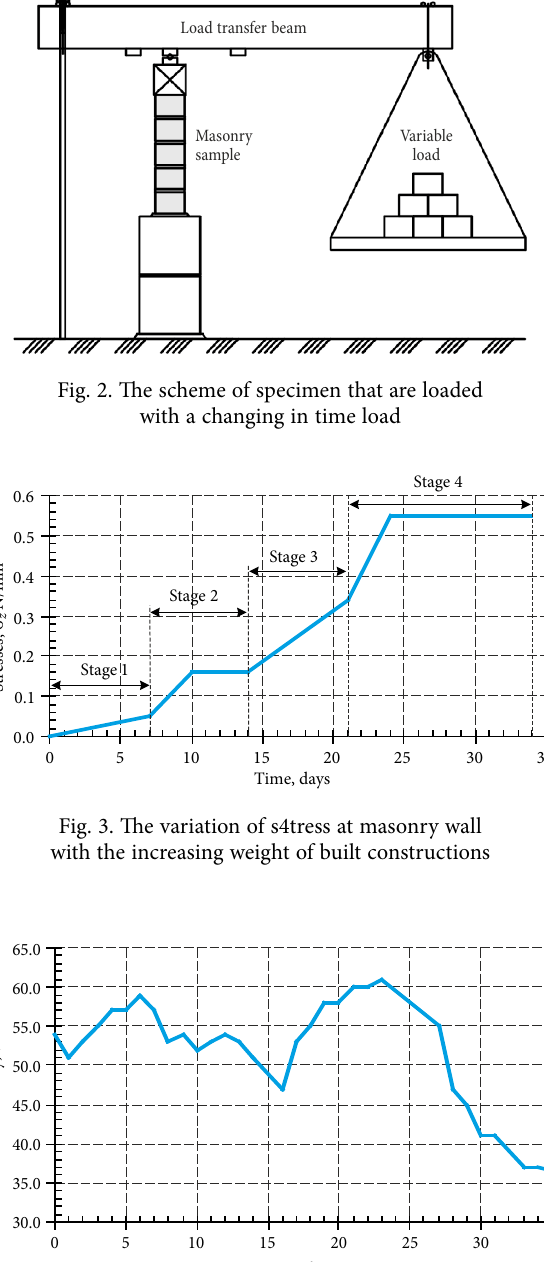
Load transfer beam